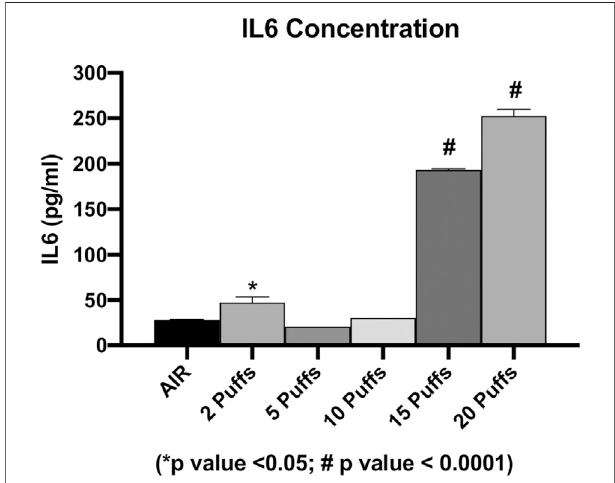
FIGURE 3 | IL6 concentration as a function of puff number of cigarettes 1R6F smoked under HCI (Health Canada Intense) regime. p values were calculated between each puff number vs. AIR control.